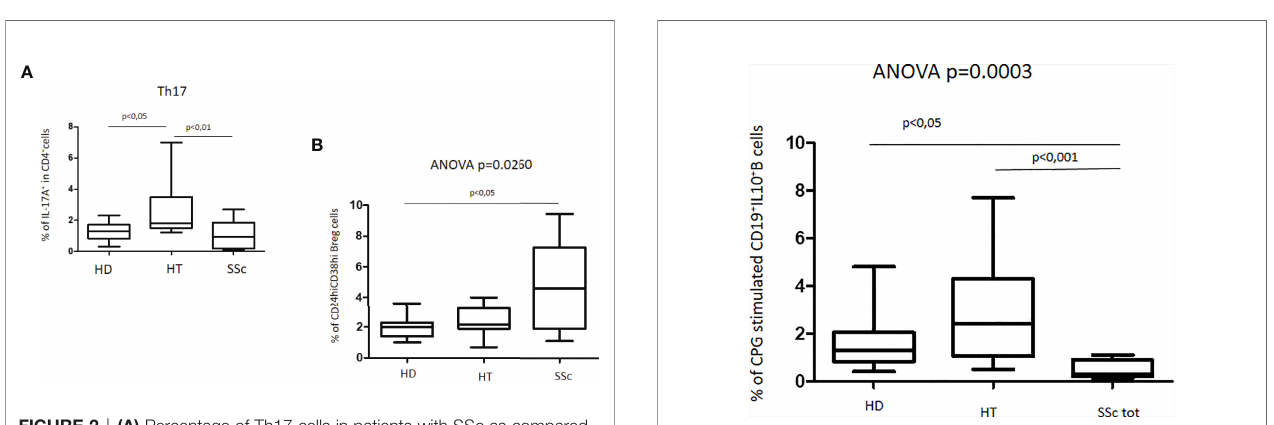
FIGURE 3 | Percentage of CpG-stimulated CD19 + IL10 + B cells in patients with SSc as compared with both HT patients and healthy donors (HD). Kruskal – Wallis followed by Dunn posttest was used for multiple comparisons.